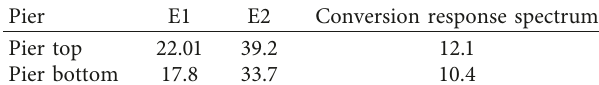
Table 5: Pier displacement (unit: